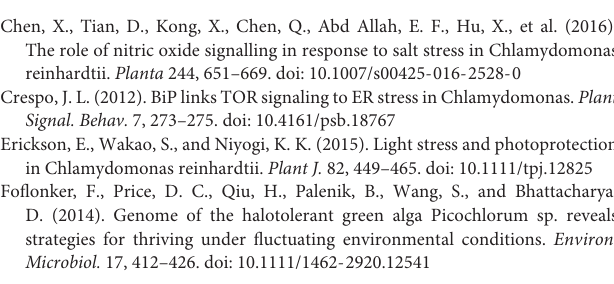
reinhardtii strain GY-D55. Supplementary Table 4 | The 12,445 differentially expressed genes in the eight clusters. Supplementary Table 5 | The Gene Ontology (GO) enrichment results of the eight differentially expressed gene clusters. Supplementary Table 6 | Summary of the differentially expressed transcription factors. Supplementary Table 7 | Gene number and edge number of 44 WGCNA modules. Supplementary Table 8 | The GO enrichment results of 44 WGCNA modules’ members. Supplementary Table 9 | Information of the quantitative real time PCR (qRT-PCR)